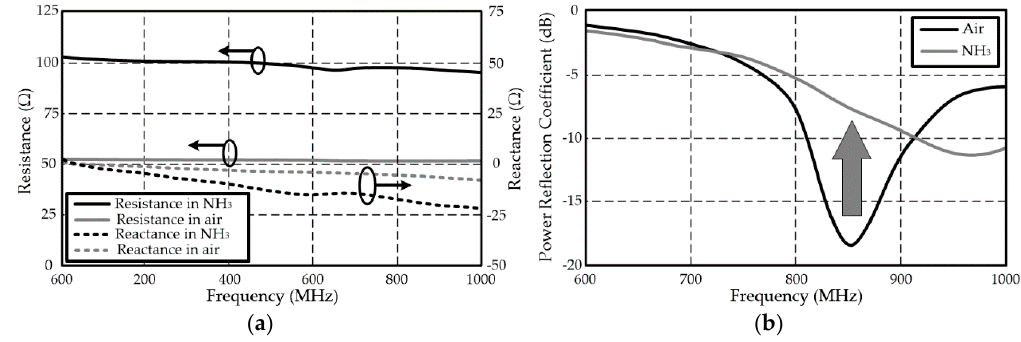
Figure 12. ( a ) Measured impedances of the SWCNT film which printed 25 layers in air/NH 3 and ( b ) the simulated power reflection coefficient of the RFID-enabled sensor with the SWCNT film before/after the gas exposure.